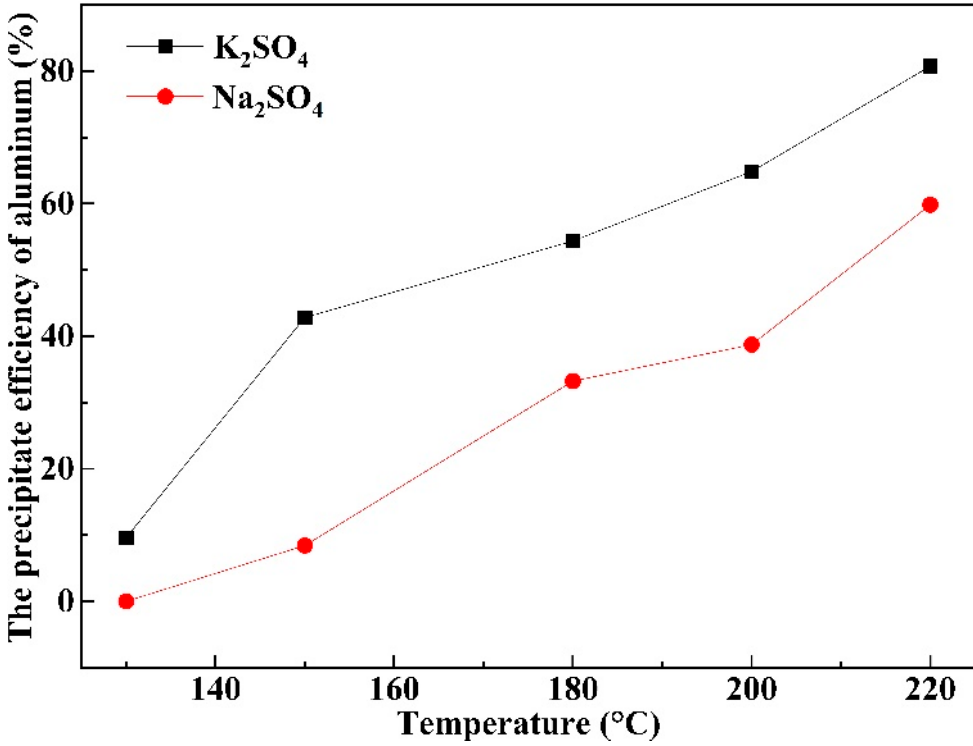
Figure 4. Effect of temperature on the precipitation efficiency of aluminum.